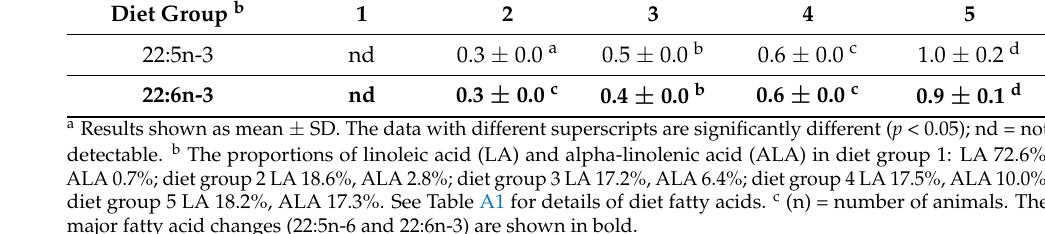
Table A1. Fatty acid composition of the diets (g/100 g fatty acids).